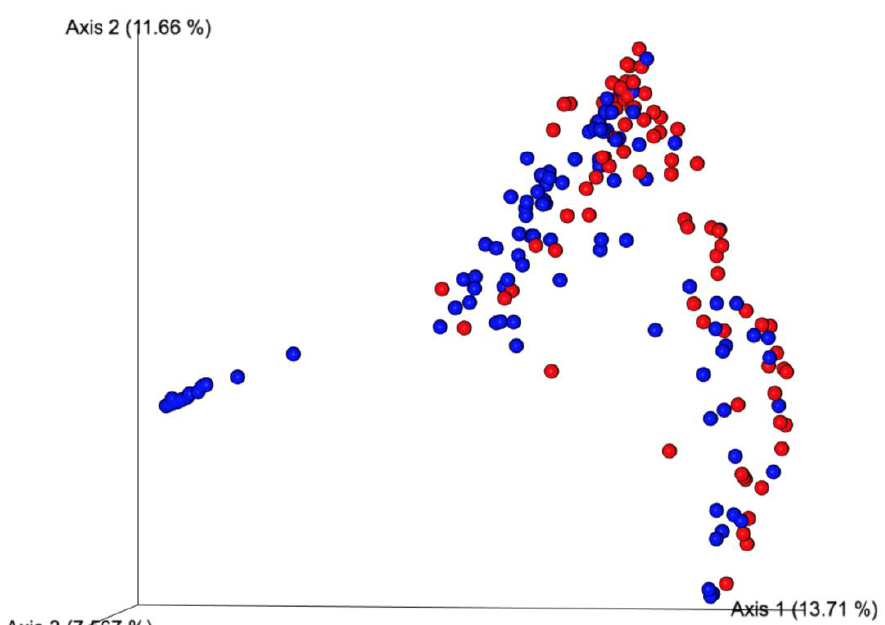
Figure 3. Principal coordinate analysis showing a subtle difference microbial clustering between pre- (blue dots) and post-treatment (red dots) samples in the combined treatment groups. Table 3. Comparisons of Bray–Curtis dissimilarity index between pre- and post-treatment samples in the treatment groups.